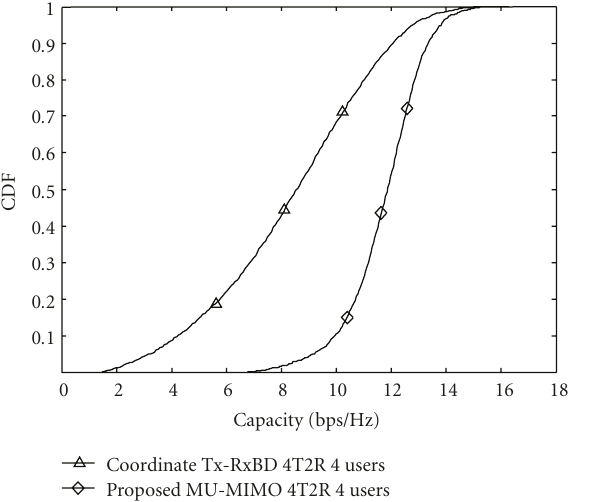
Figure 7: The BER comparison of the two schemes.